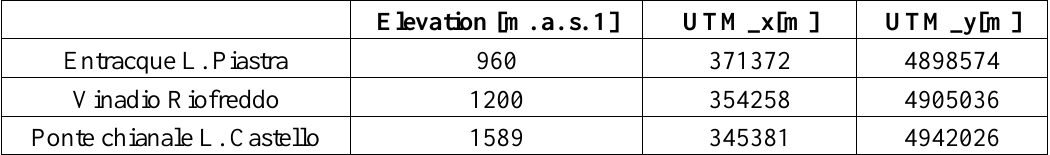
Table 1. Denomination, elevation and UTM coordinates of the three measurement sites considered in this